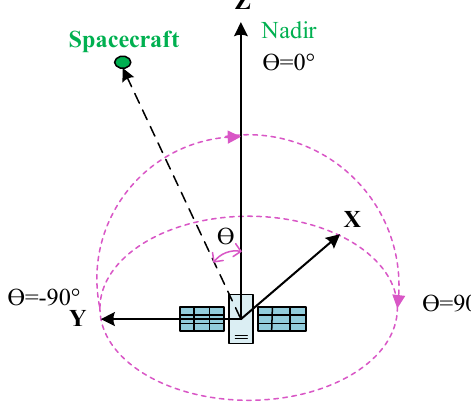
Figure 4. GNSS antenna coordinate system.